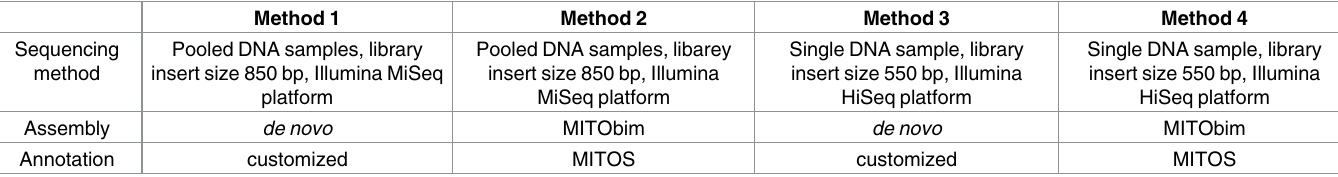
Table 1. Methods used to obtain and annotate the coccinellid